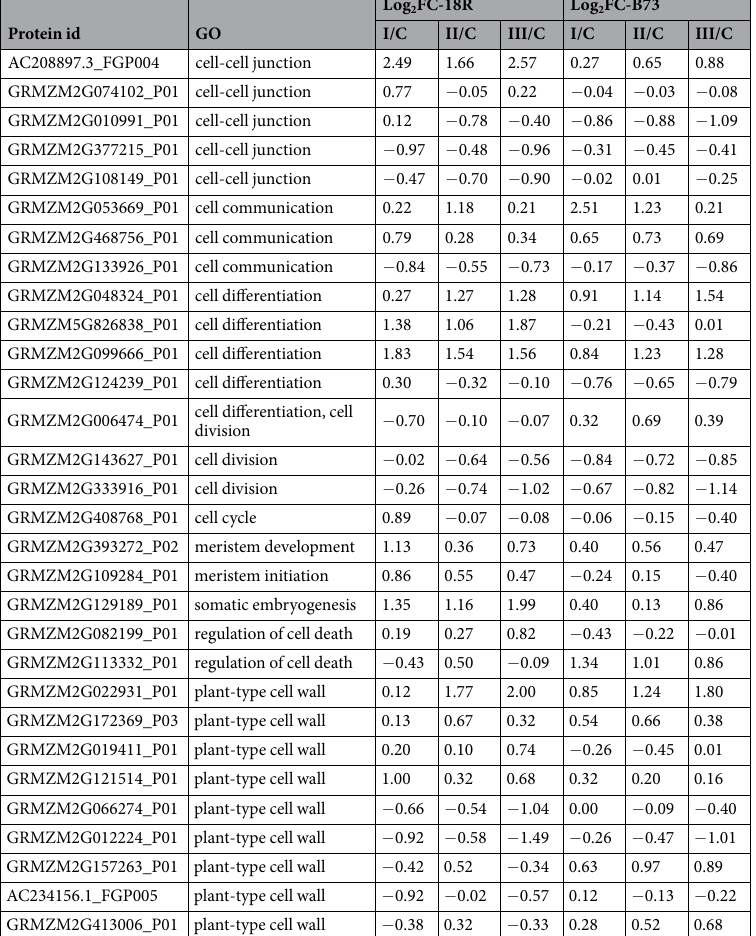
Table 2. Cell division, differentiation and dedifferentiation process related